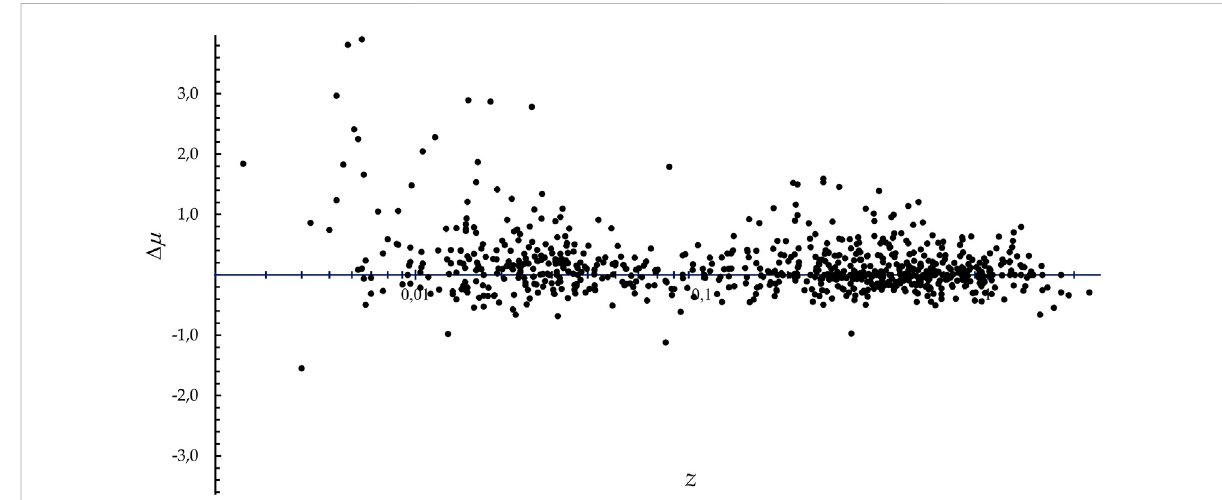
FIGURE 7 Difference, Δ μ vs. z , between the measured supernova brightness vs. redshift and the values calculated by the least-time principle (Eq.